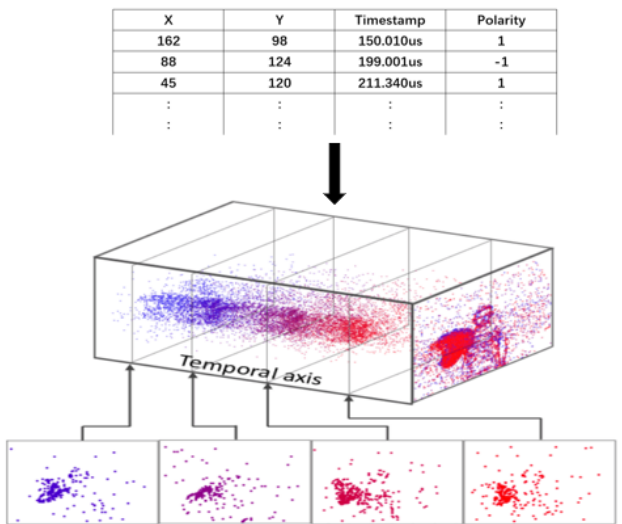
Figure 1. This picture shows how the event camera captures event data. When a new event is triggered, the event camera will only update the coordinates of the activation point instead of the full image. Event data generally include four parts: timestamp, coordinate information (x, y), and polarity. We can observe from the figure that each event data point is asynchronous. Event data is dense in the temporal domain and sparse in the spatial domain. (Data source adapted with permission from